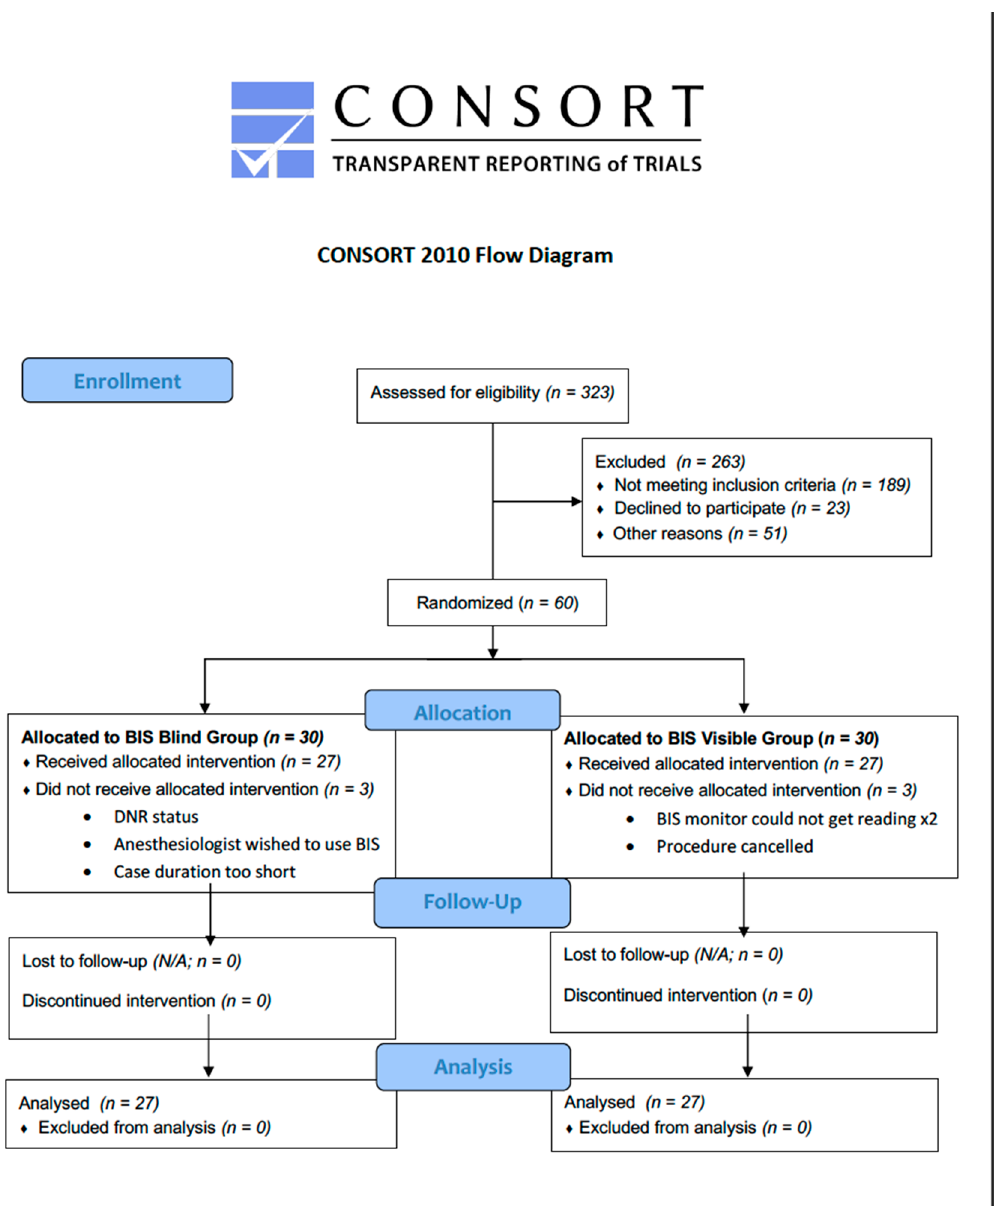
Figure 1. CONSORT 2010 Flow Diagram. Table 1. Detailed reasons (number of patients) for meeting exclusion criteria.